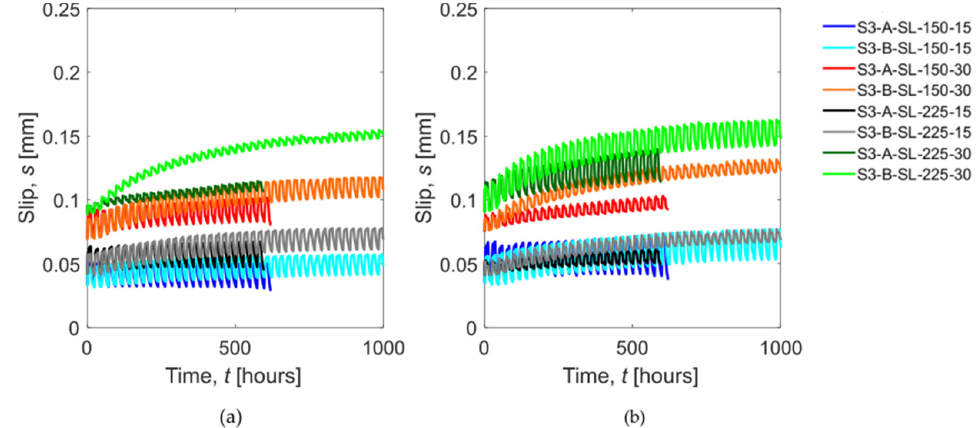
Figure 6. Comparison of the slip evolution with time obtained in series S3-A and S3-B for groove thicknesses of: ( a ) 7.5 mm; ( b ) 10 mm.